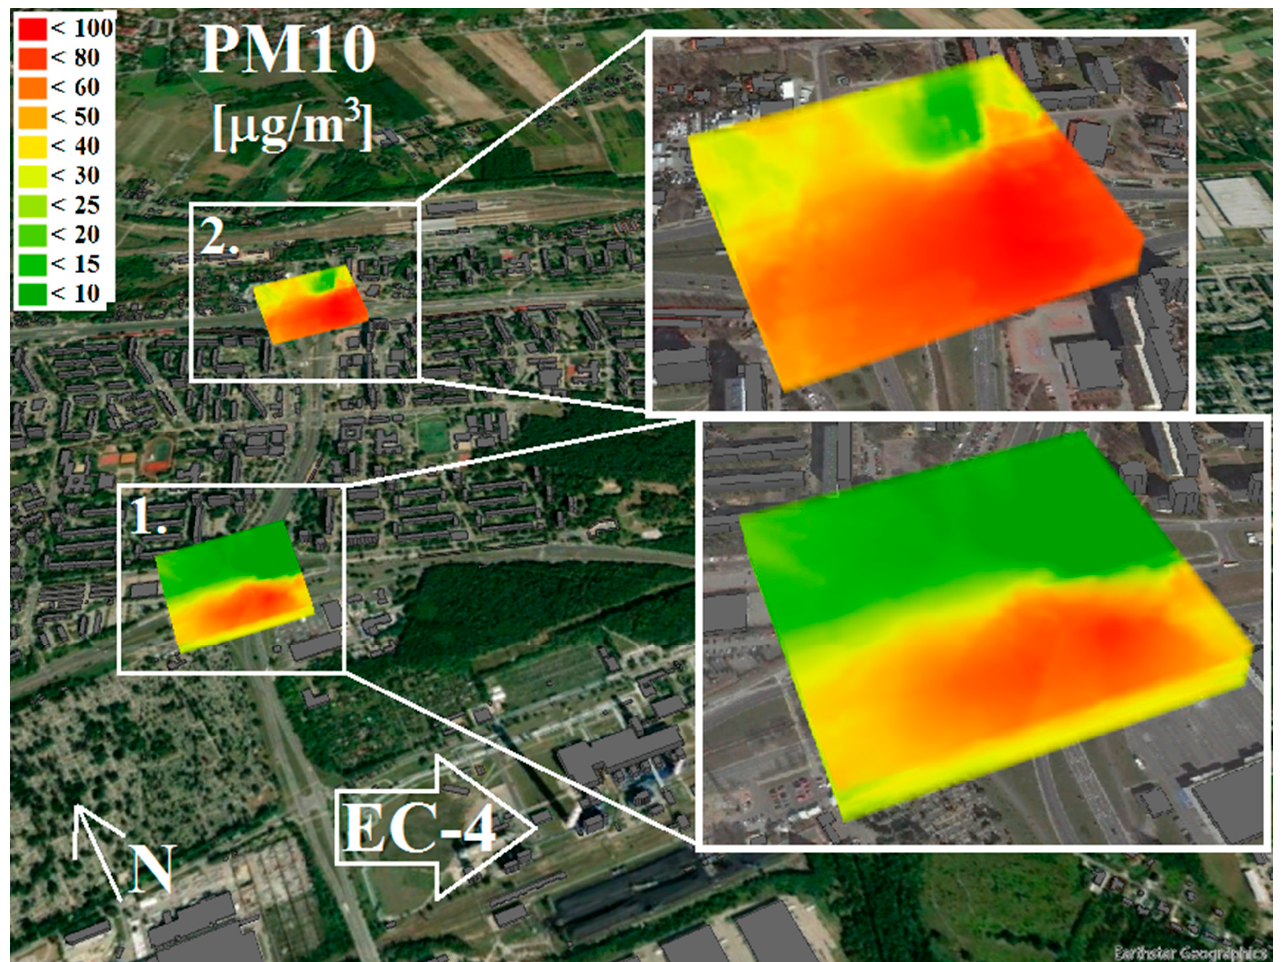
Figure 11. Spatial distribution of PM 10 concentration for a selected location in the vicinity of EC-4.